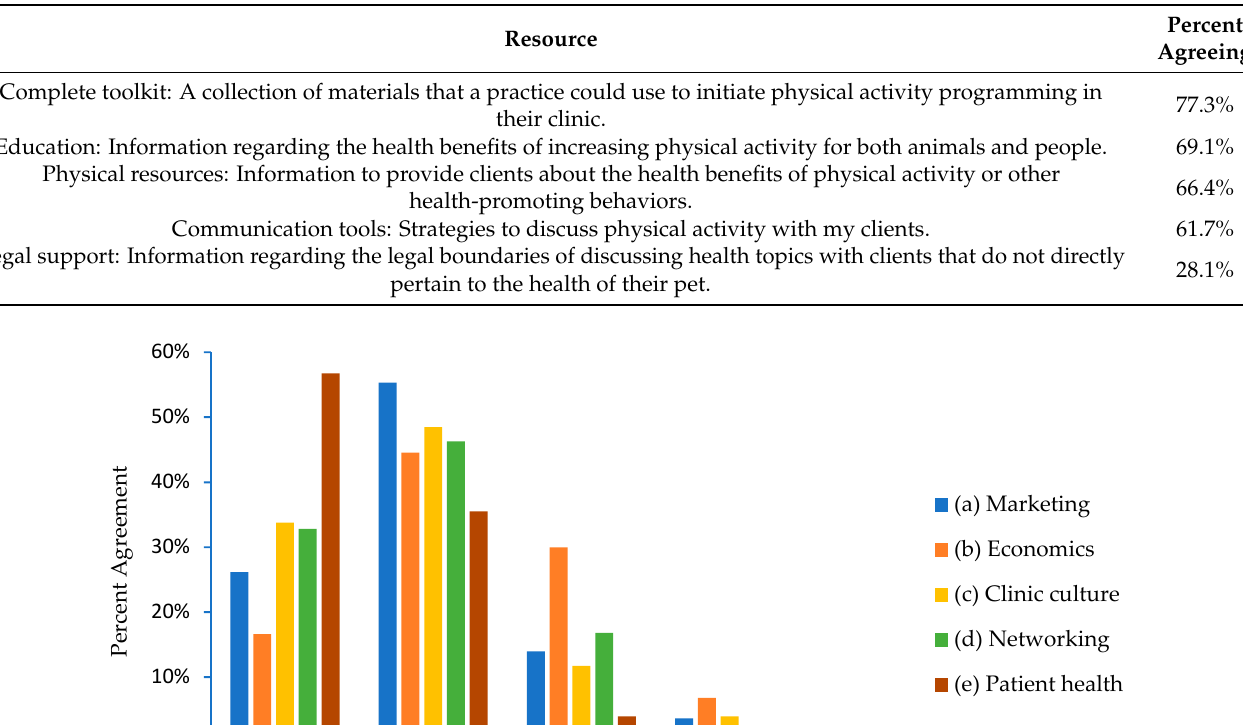
Table 8. Resources veterinary staff (n = 631) believe would help them promote healthy behaviors for their clients and pets. Complete toolkit: A collection of materials that a practice could use to initiate physical activity programming in